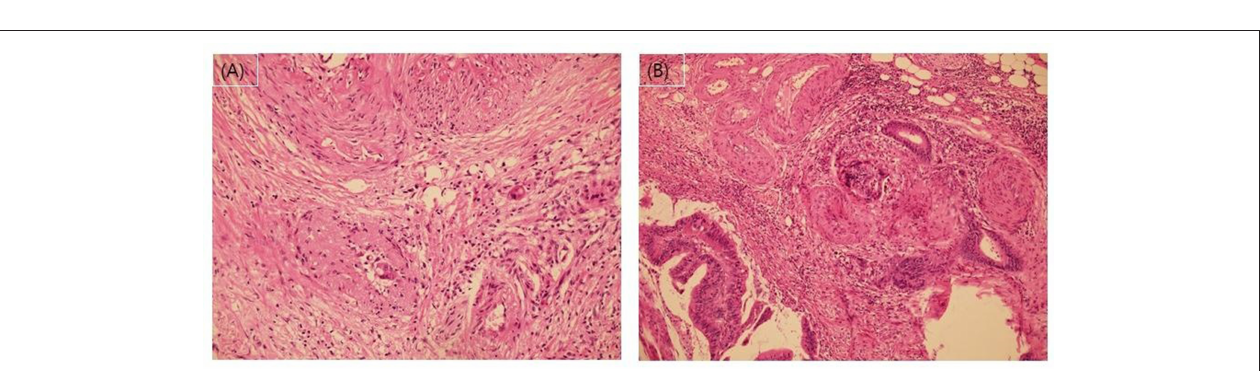
FIGURE 2 | (A) and (B) Microphotographs of vascular invasion using hematoxylin and eosin